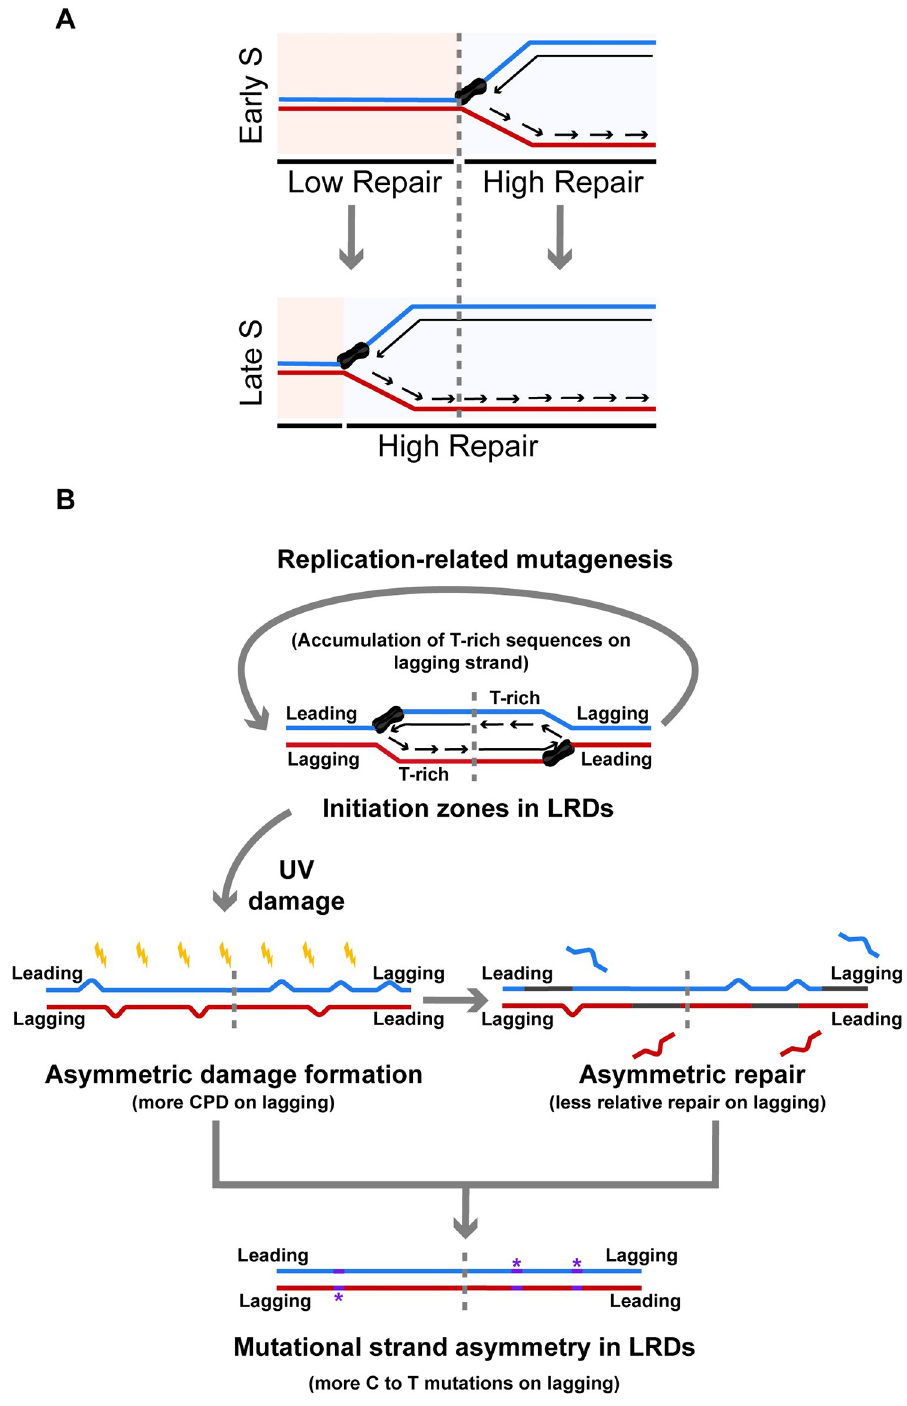
Fig 6. The impacts of replication domains on damage formation and repair and related mutagenesis. (A) Relaxation of compact chromatin by DNA replication progress promotes local repair. (B) Model showing the relationship among replication, sequence context, CPD formation, nucleotide excision repair and mutation accumulation in LRDs. Replication could cause the accumulation of T-rich sequences on lagging strands in LRDs, which contributes to favorable CPD formation and repressed repair and finally results in the strand asymmetry of mutation in the melanoma genome. Blue and red strands represent the plus- and minus strands, respectively. Gray strands represent the resynthesized strands and C to T mutations are represented as purple